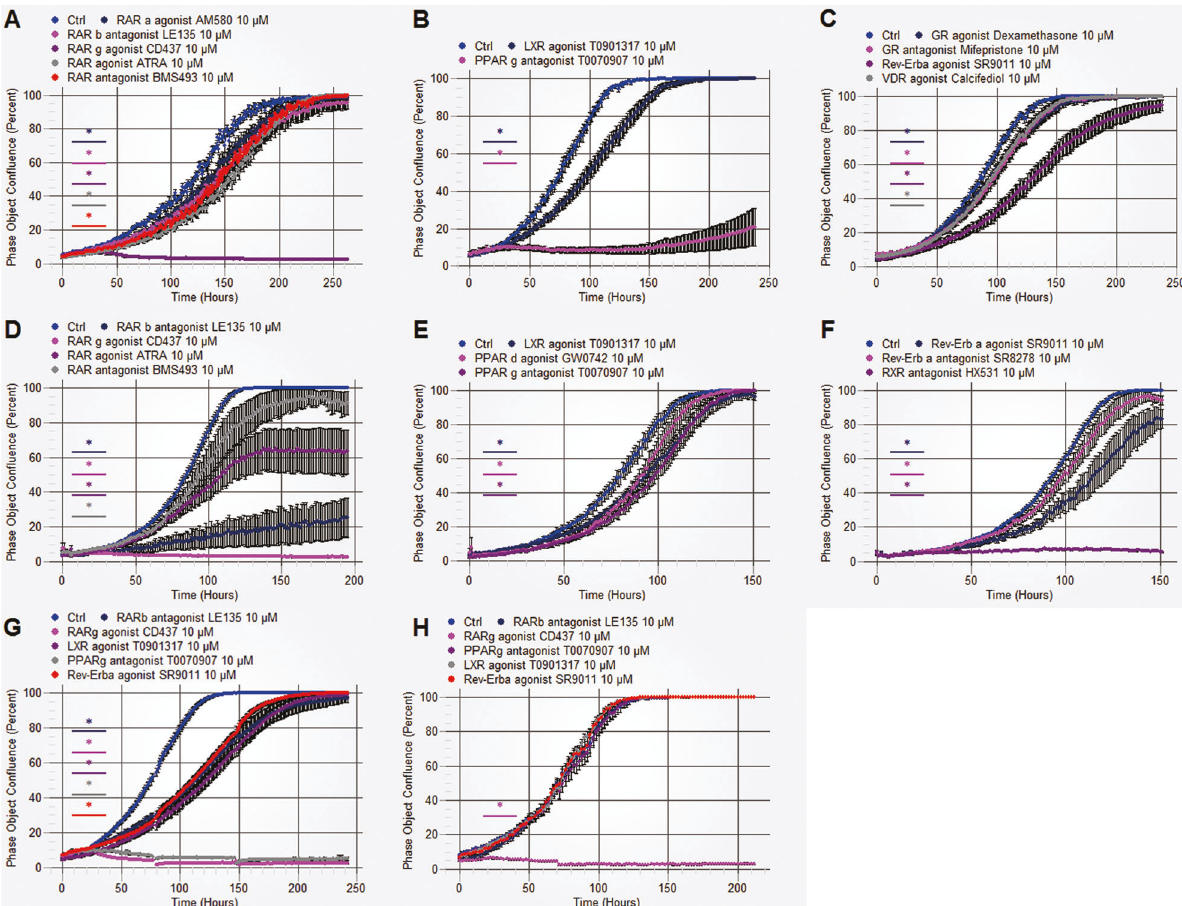
Fig. 1 Identi fi cation of candidate NR modulators for inhibiting osteosarcoma cell growth. U2OS and HOS-MNNG cells were treated with the 29 indicated NR modulators that target 17 NRs at a concentration of 10 μ M. A – C Eleven NR modulators signi fi cantly inhibited U2OS cell growth. D – F Ten NR modulators signi fi cantly inhibited HOS-MNNG cell growth. Saos-2 ( G ) and hFOB 1.19 ( H ) cells were treated with the 5 indicated modulators that targeted a single nuclear receptor at a concentration of 10 μ M. The cell con fl uence was evaluated in real time by the IncuCyte Zoom living cell imaging system. Mean ± SD, n = 6; *P < 0.05, the NR modulator group versus the Ctrl